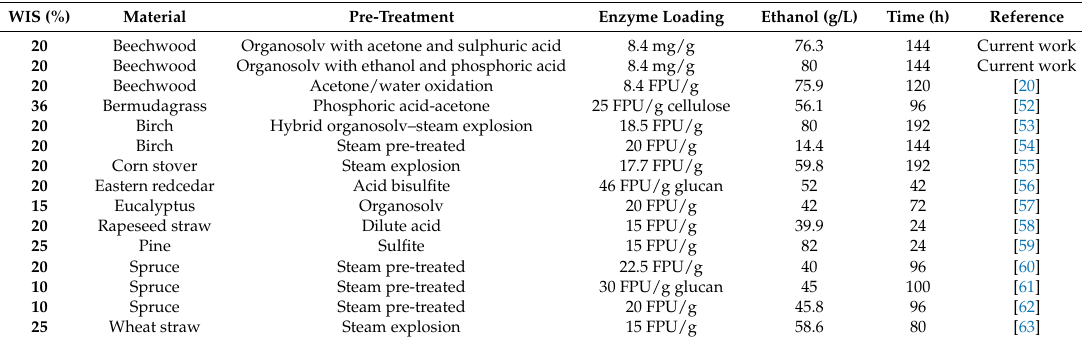
Table 5. Work found in the literature on high gravity (HG) SSF for ethanol